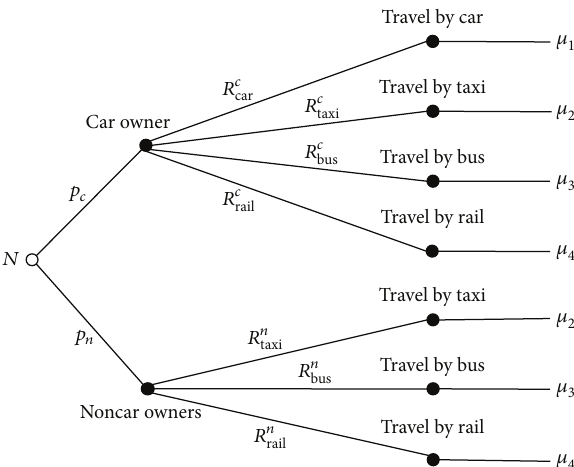
Figure 1: Extensive form of travel mode choice game.